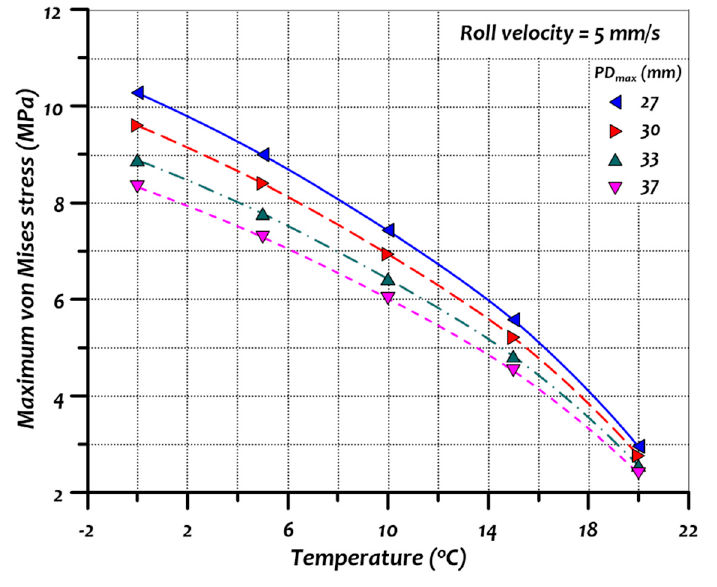
Figure 18. Effect of material temperature on maximum von Mises stress at V = 5 mm/s (Note: PD max = maximum plug diameter).